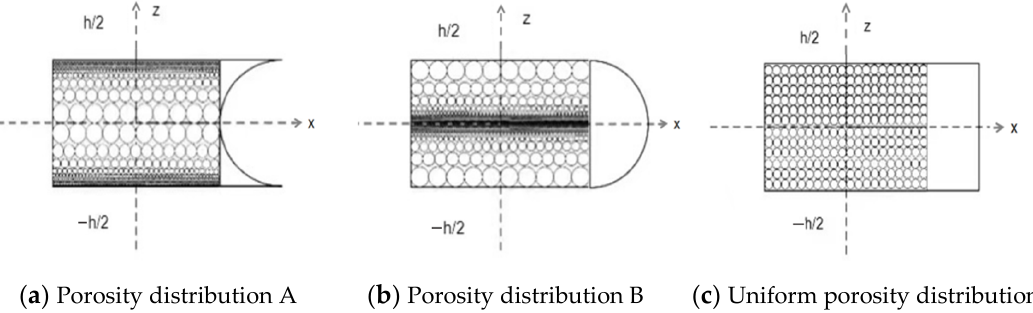
Figure 1. Three types of porosity distributions.